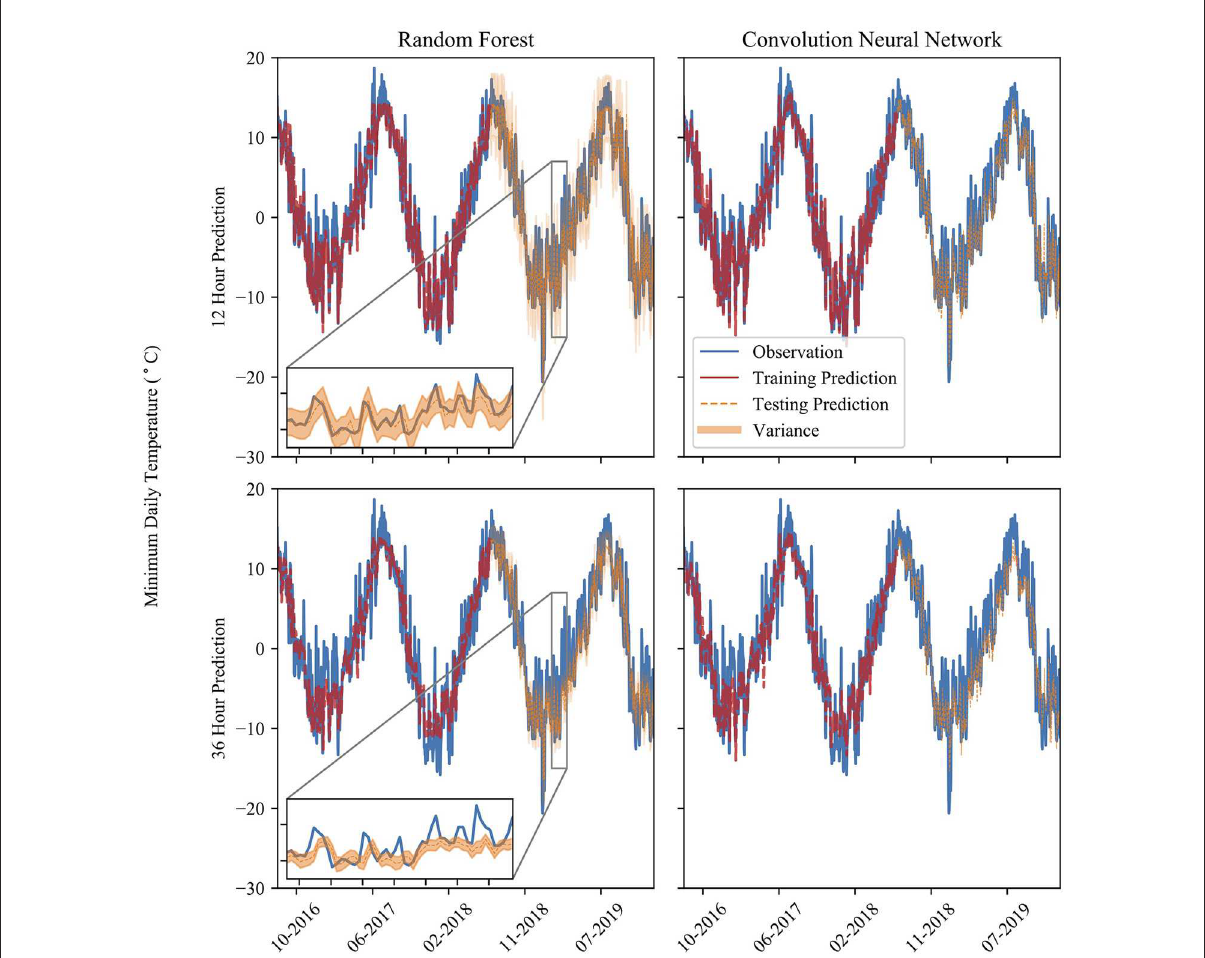
FIGURE2 The time series of temperature prediction and observation at various prediction times (over a span of 3 years) and models. Model predictions show both training and testing datasets. The inset shows a period of 50 days from 01/29/2019 to 03/20/2019. The orange band is the 90% confidence interval of the RF model